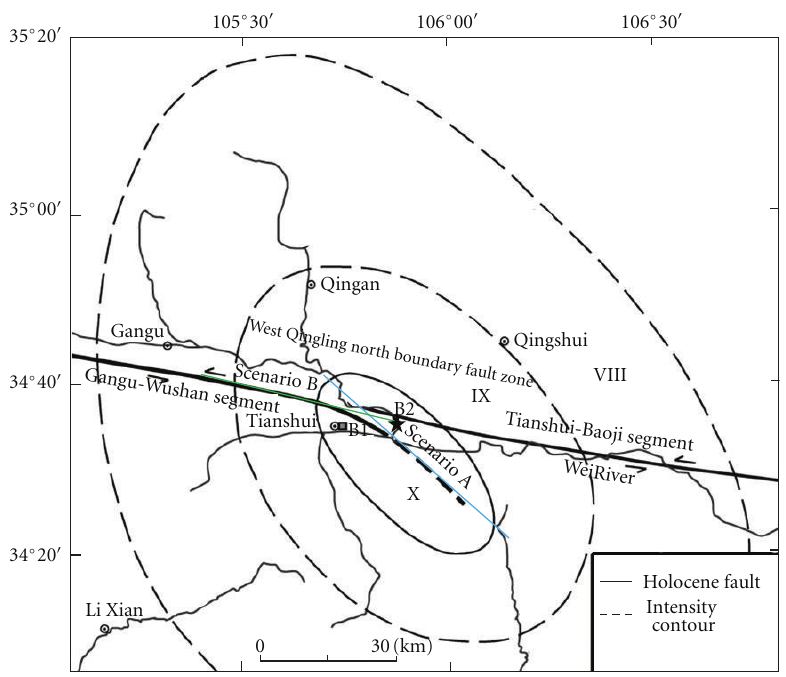
Figure 5: Gangu-Wushan and Tianshui-Baoji faults and scenario earthquake for Tianshui. Table 1: Crustal velocity structure in the Tianshui